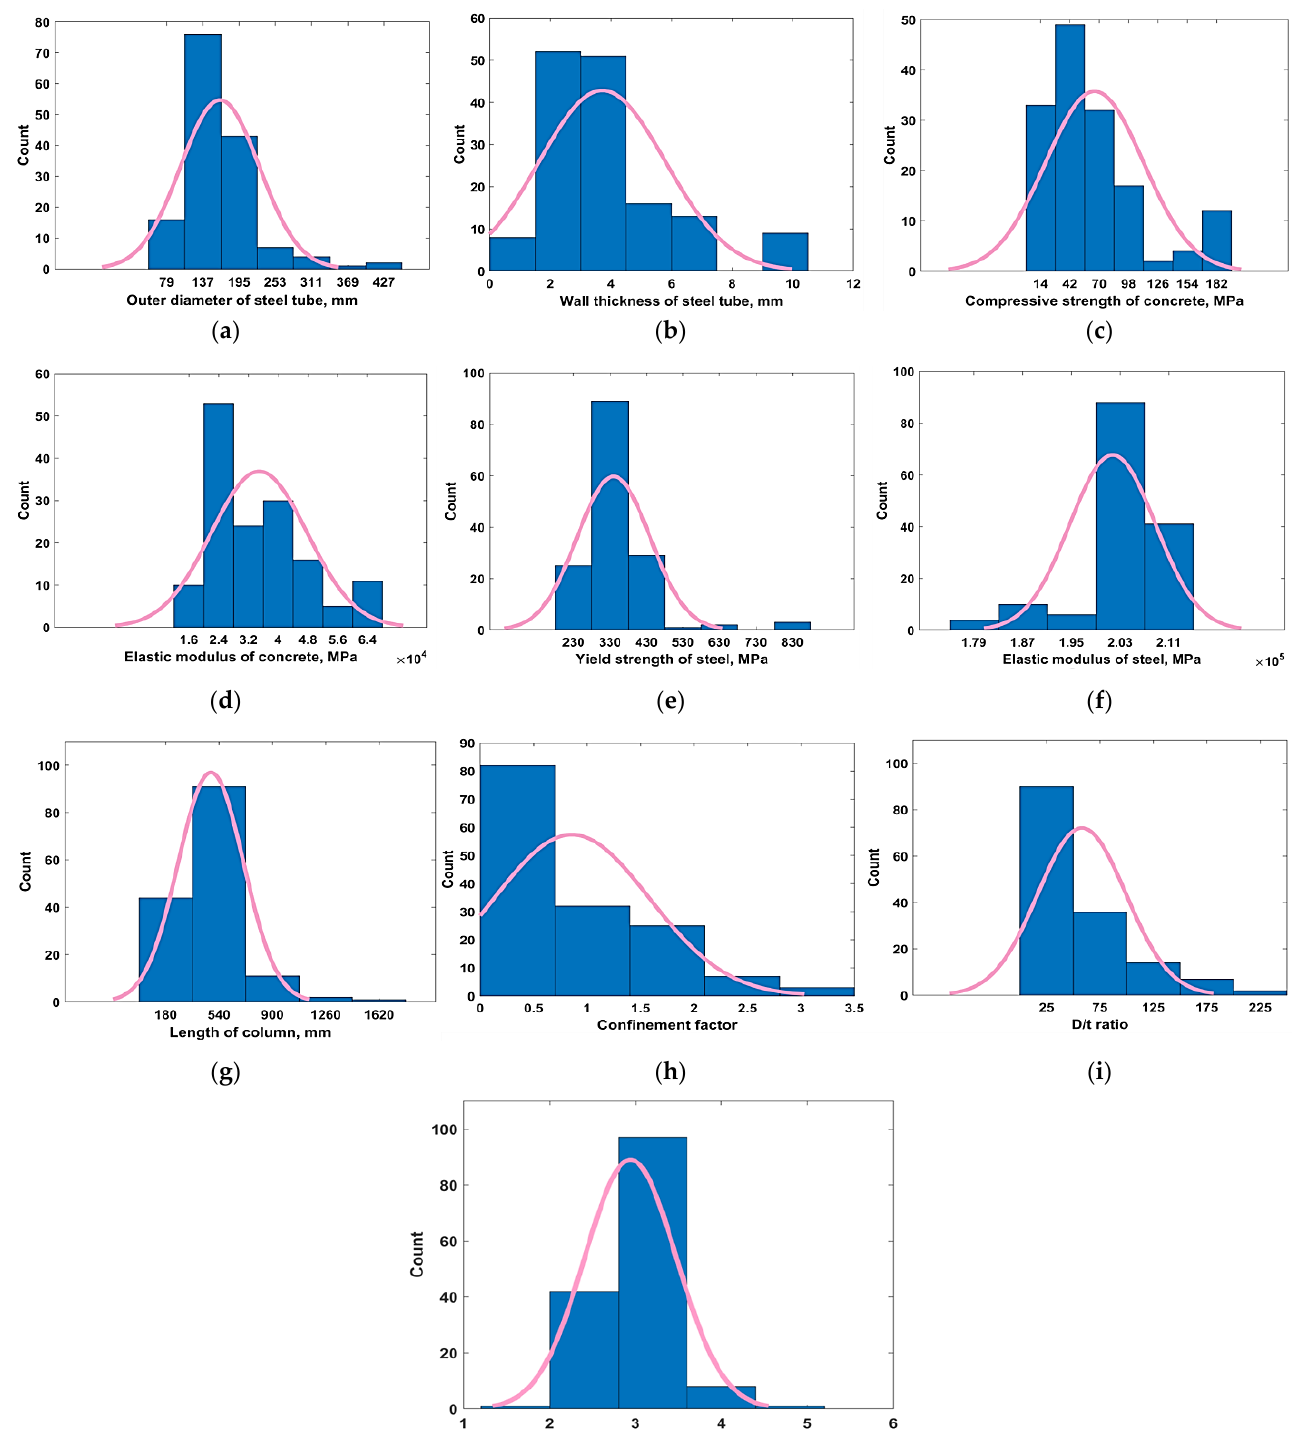
Figure 1. Frequency histograms of input variables. ( a ) Elastic modulus of concrete, ( b ) wall thickness of steel tube, ( c ) compressive strength of concrete, ( d ) Elastic modulus of concrete, ( e ) Yield strength of steel, ( f ) Elastic modulus of steel, ( g ) Length of column, ( h ) Confinement factor, ( i ) D/t, ( j ) L/D.